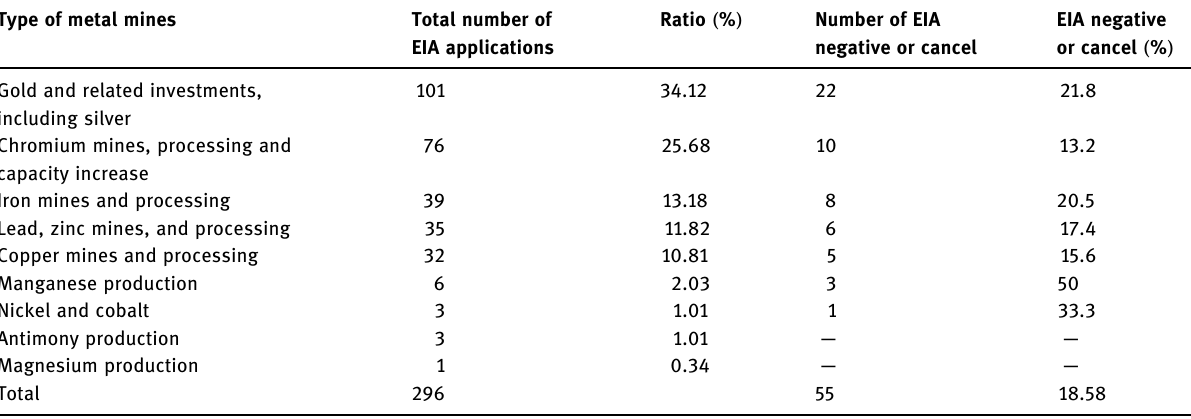
Table 3: Type distribution of metal mines applying for EIA and EIA negative or cancel rates Type of metal